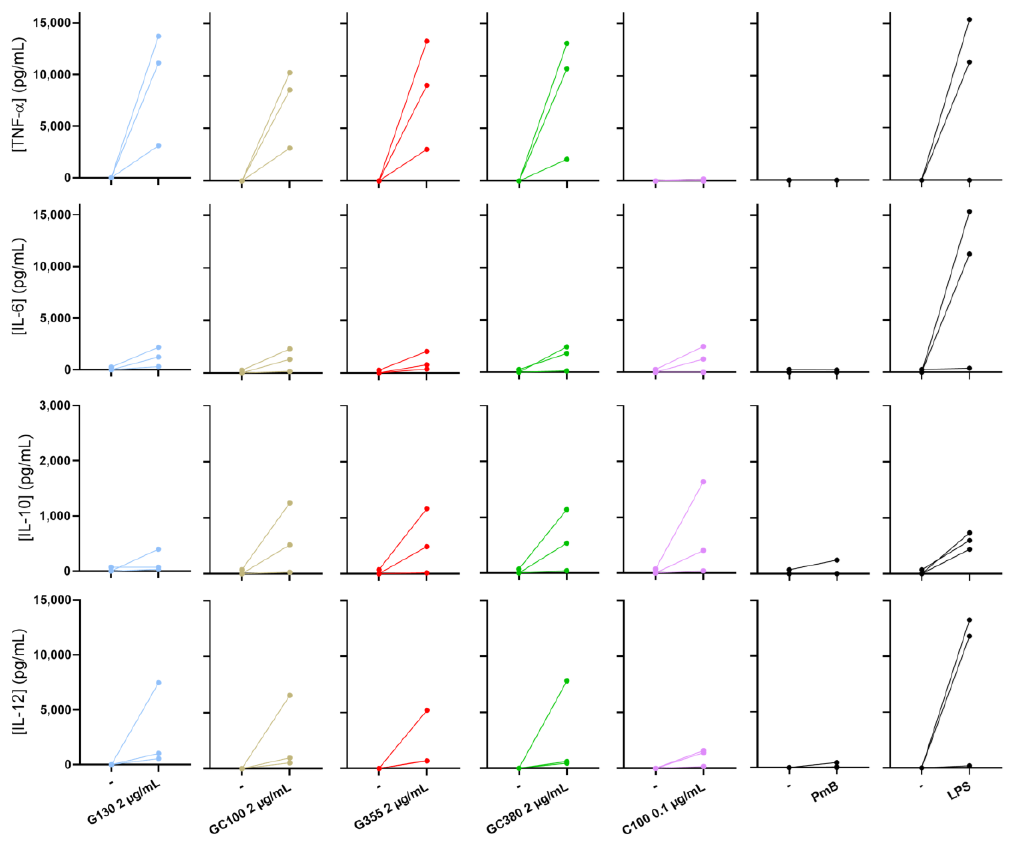
Figure 5. Effects of the curcumin-loaded glucan NPs, blank NPs, and free curcumin in the presence of polymyxin B (PmB), on TNF- α, IL -6, IL-10 and IL-12 secretion by human Mo-DCs, after 24 h of incubation. LPS (20 ng/mL) was used as the positive control. The results display the increase in cytokine secretion compared with the donors’ basal level (– ). Data are represented as the mean ± SEM, n = 3.